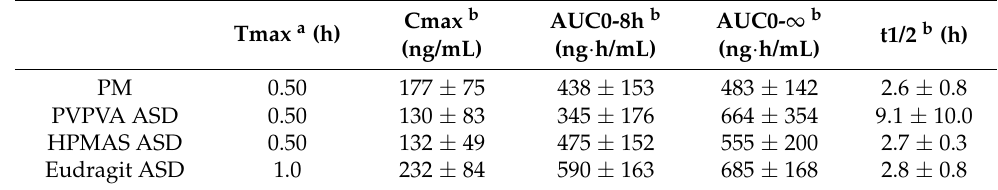
Table 3. Pharmacokinetic parameters after the oral administration of NFT